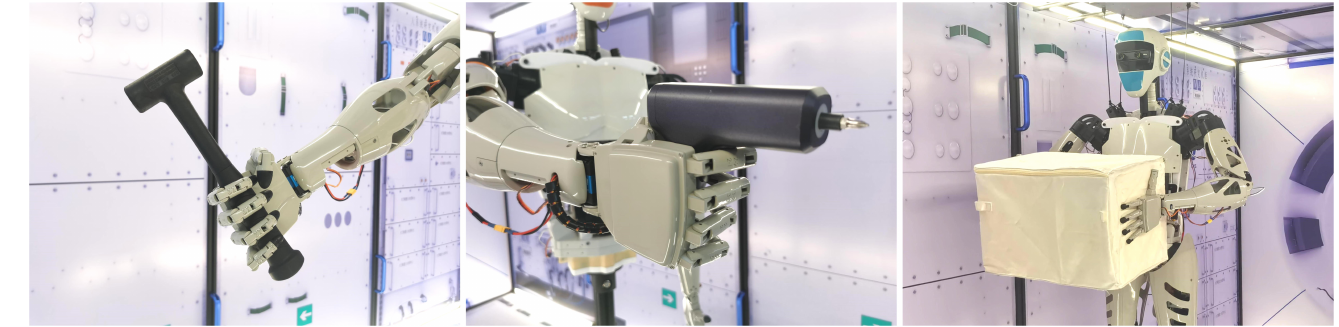
Figure 11. Taikobot can handle a variety of tools and transport large cargoes with dual arm system.